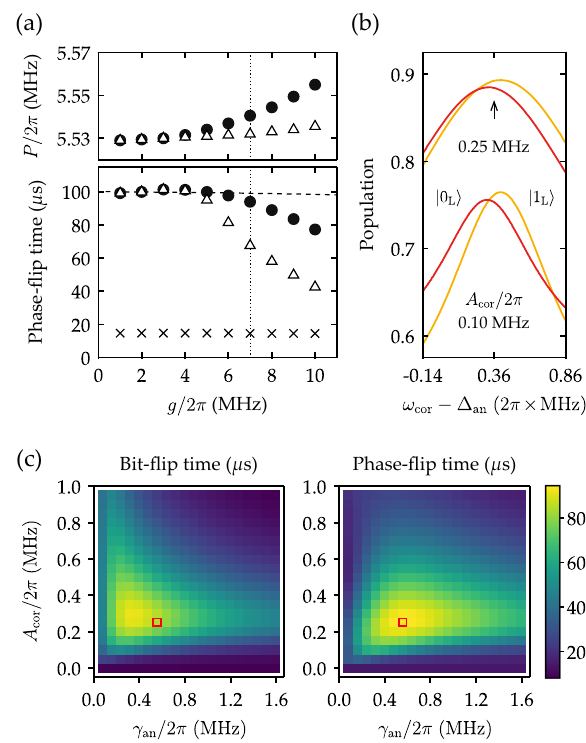
Fig. 3 Optimization procedure. a Upper panel: Four-photon pump amplitude as a function of the KPO – ancilla coupling constant. The solid circle indicates the pump amplitude where the phase- fl ip time is maximized and the empty triangle indicates the pump amplitude where quasienergy levels are degenerate. Lower panel: Phase- fl ip time with two different four-photon pump amplitudes. The symbols are the same as those in the upper panel, except the cross symbol indicates the phase- fl ip time without AQEC. The dashed horizontal line indicates T 2 in the 0 j i and 1 j i encoding. The dotted vertical line indicates the coupling constant that we used in this work, g /2 π = 7 MHz. b Populations of the logical qubit states as a function of ω cor after 10 μ s of evolution with A cor /2 π = 0.10 and 0.25 MHz. The arrow indicates the frequency we used as the optimal ω cor . c Bit- and phase- fl ip times as a function of A cor and γ an at the optimal ω cor . The red squares, where the phase- fl ip time is maximized, indicate the conditions used in Fig.